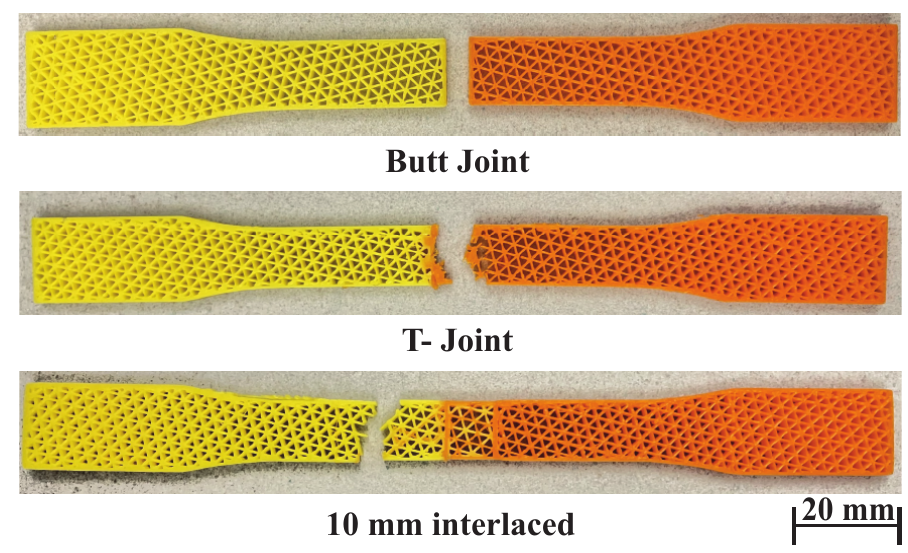
Figure 13. Fractured samples of butt joint, T-joint, and interlaced